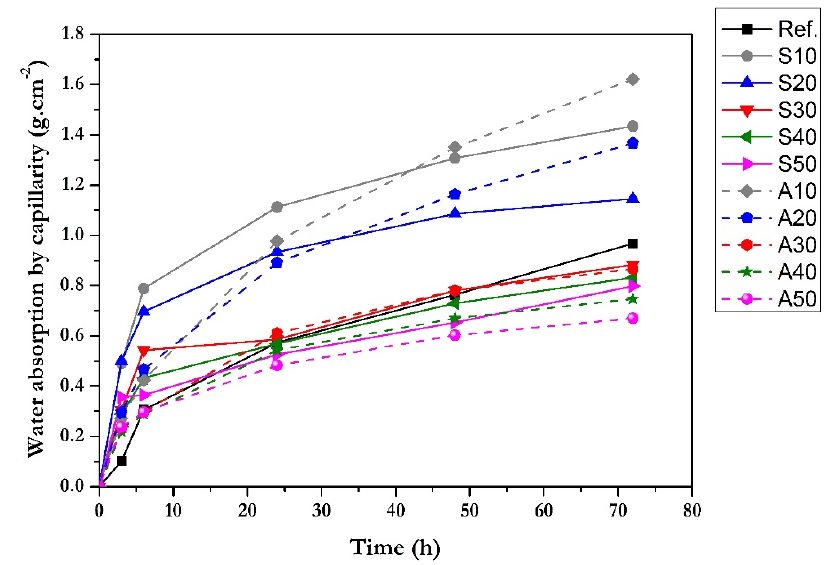
Figure 7. Water absorption by capillarity at 28